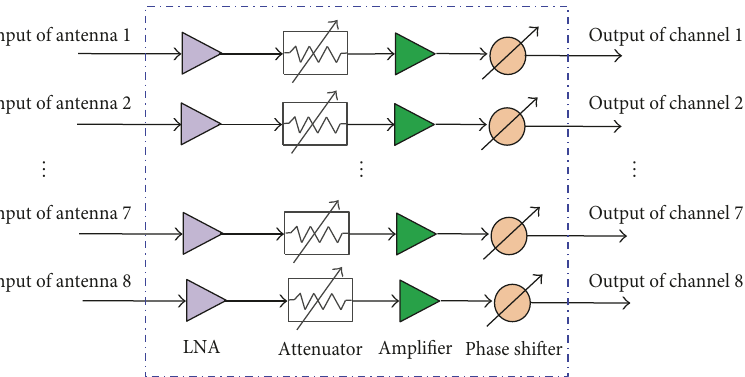
Figure 11: Active receiving circuits in a RF receiver module.